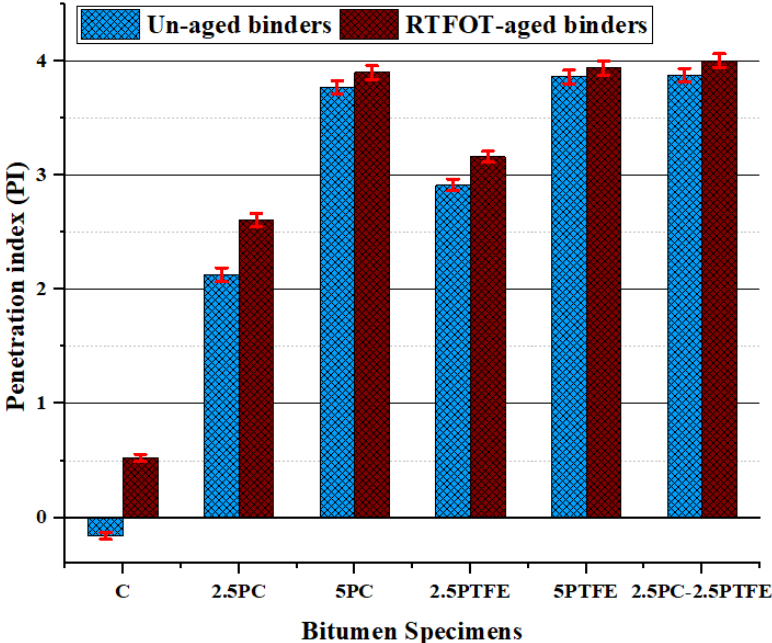
Figure 6. The penetration index values of binders before and after aging.